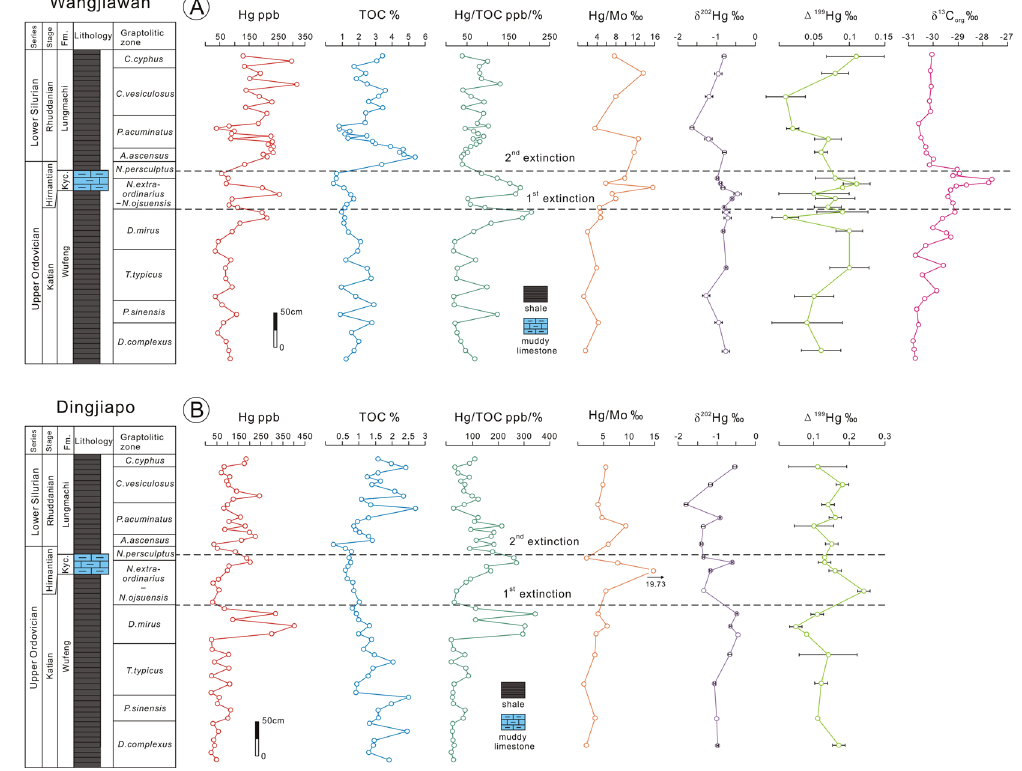
Figure 3. Geochemical plots for Wangjiawan ( A ) and Dingjiapo ( B ) sections across the Ordovician-Silurian boundary. Plots show variation of δ 13 C org for Wangjiawan and Hg, TOC, Hg/TOC, Hg/Mo, δ 202 Hg and Δ 199 Hg for Wangjiawan and Dingjiapo. Graptolitic zone is from Chen et al . 35 and δ 13 C org data are from Yan et al . 40 . Abbreviation: Fm. = Formation, Kyc. =